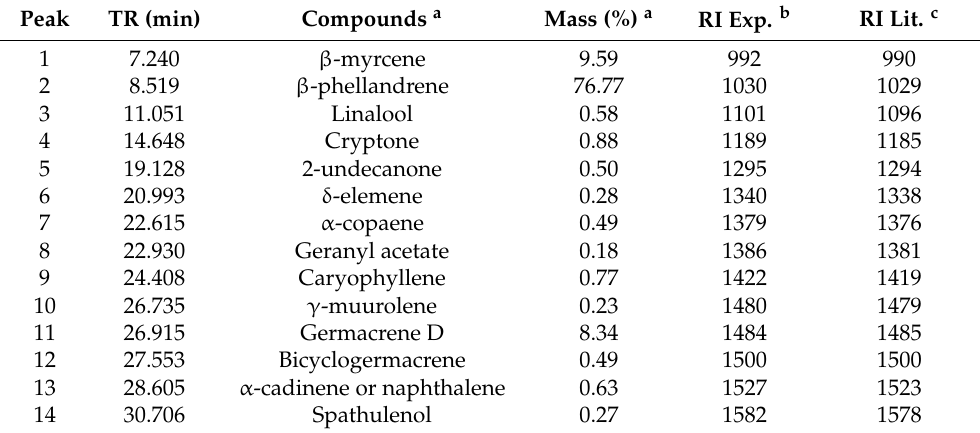
chromatography-mass spectrometry (GC-MS).